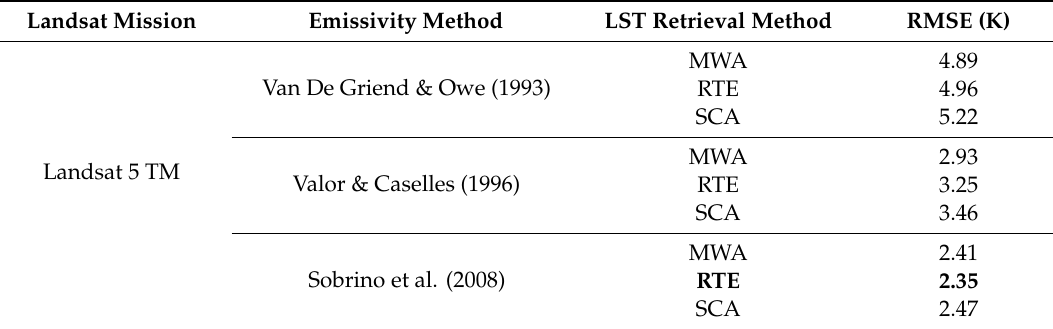
Table 5. Validation results of the Land Surface Temperature (LST) retrieval methods for Landsat 5 Thematic Mapper (TM) data based on di ff erent Land Surface Emissivity (LSE) models. The best result is in bold.